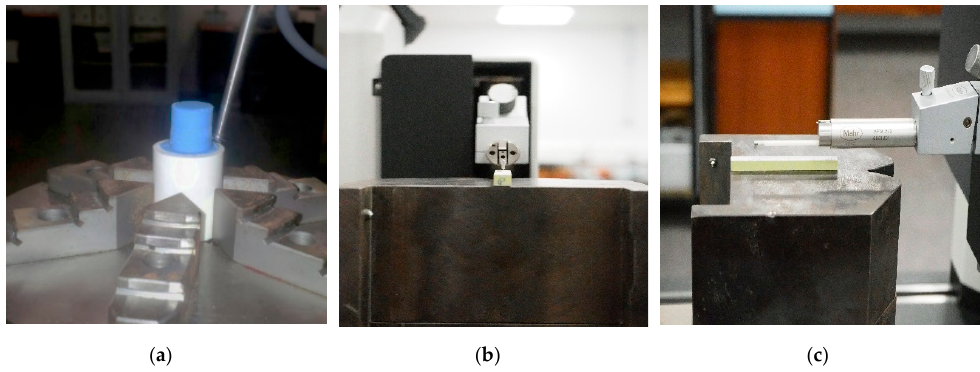
Figure 3. ( a ) Measure of replica to obtain geometrical results; ( b ) measure of roughness of UNS A97075, front view; ( c ) measure of roughness of UNS A97075, side view.